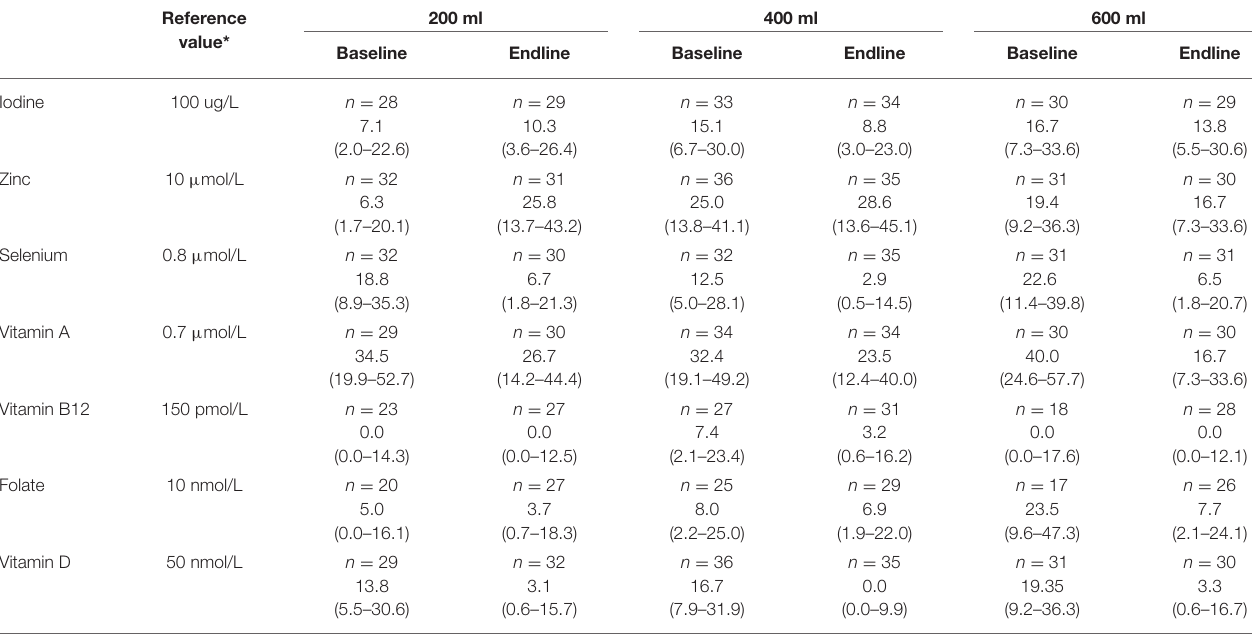
TABLE 4 | Prevalence (%) of sub-normal base- and end-line micronutrient status in the modified PP population of malnourished Nigerian toddlers who received a fortified dairy-based drink in daily amounts of 200, 400 or 600ml, during 6 months.